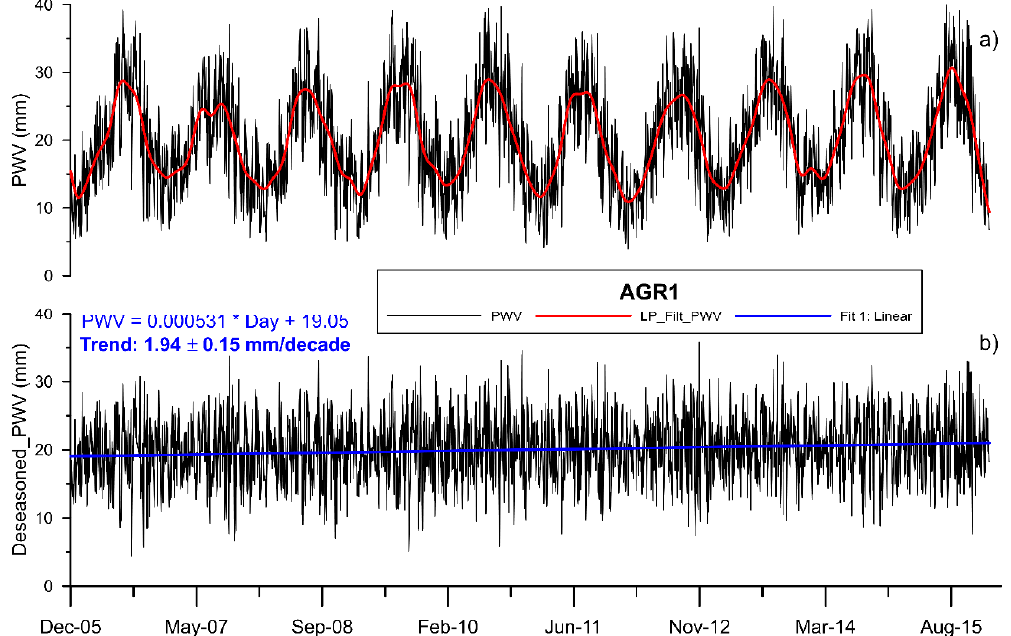
Figure 2. Time evolution of the PWV from 2006 to 2016 at AGR1 station ( a , b ) assessment of decadal trend (blue curve) after removal of an annual periodic component (red curve).